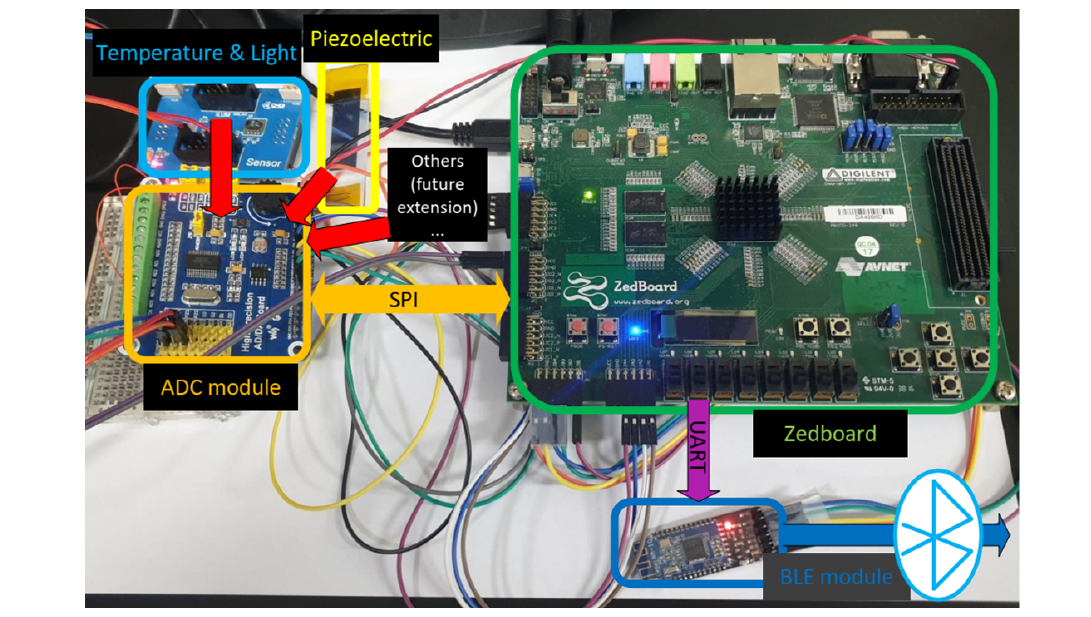
Figure 2. The proposed hardware platform.